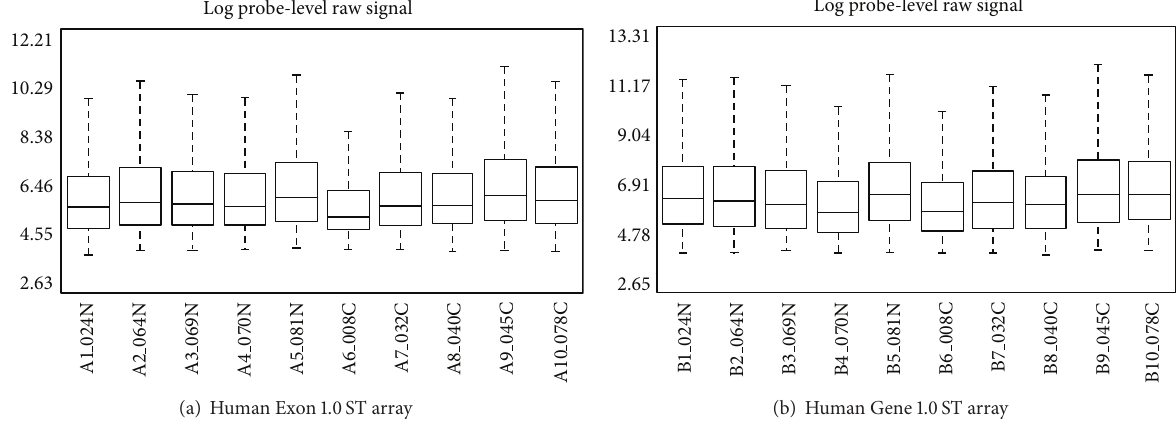
Figure 1: Distribution (boxplot) of the probe-level raw signal derived from (a) the Human Exon 1.0ST array and (b) the Human Gene 1.0 ST.